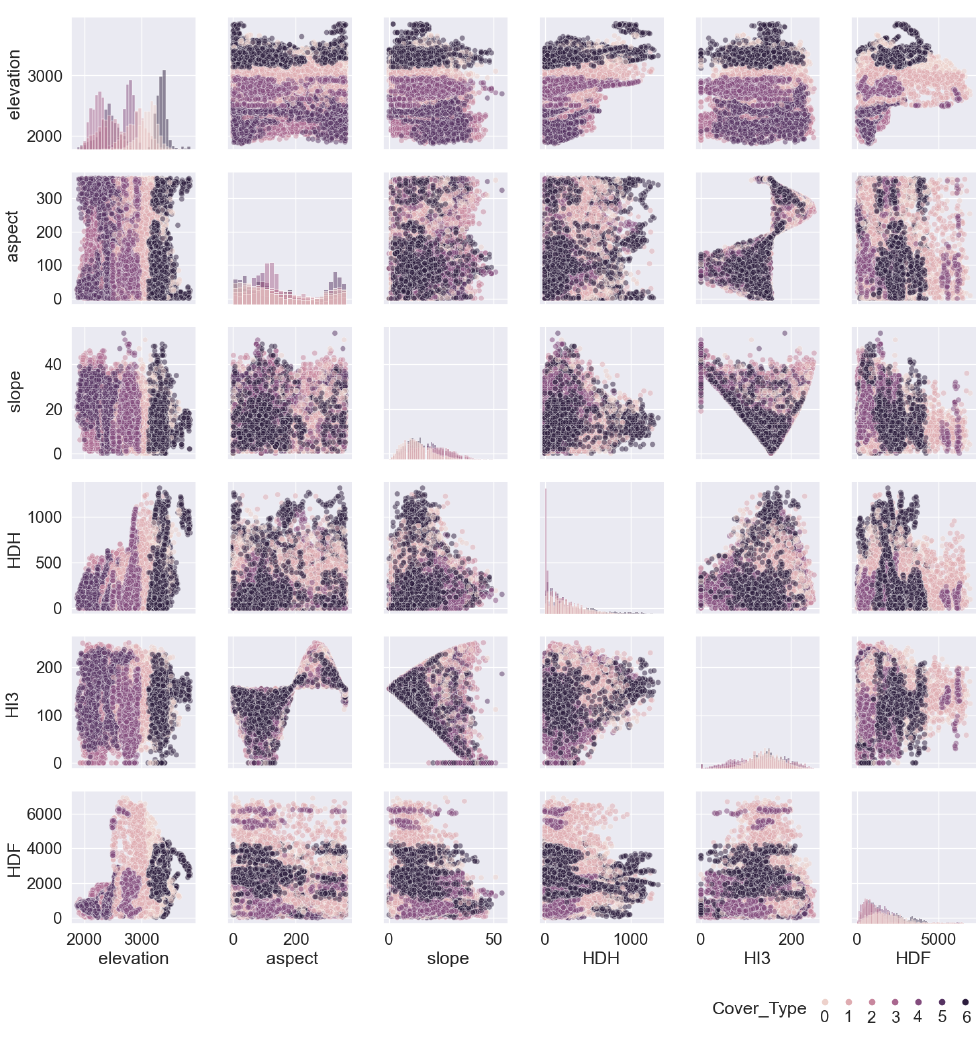
Figure 3. Pairwise distribution and relationship of features in the